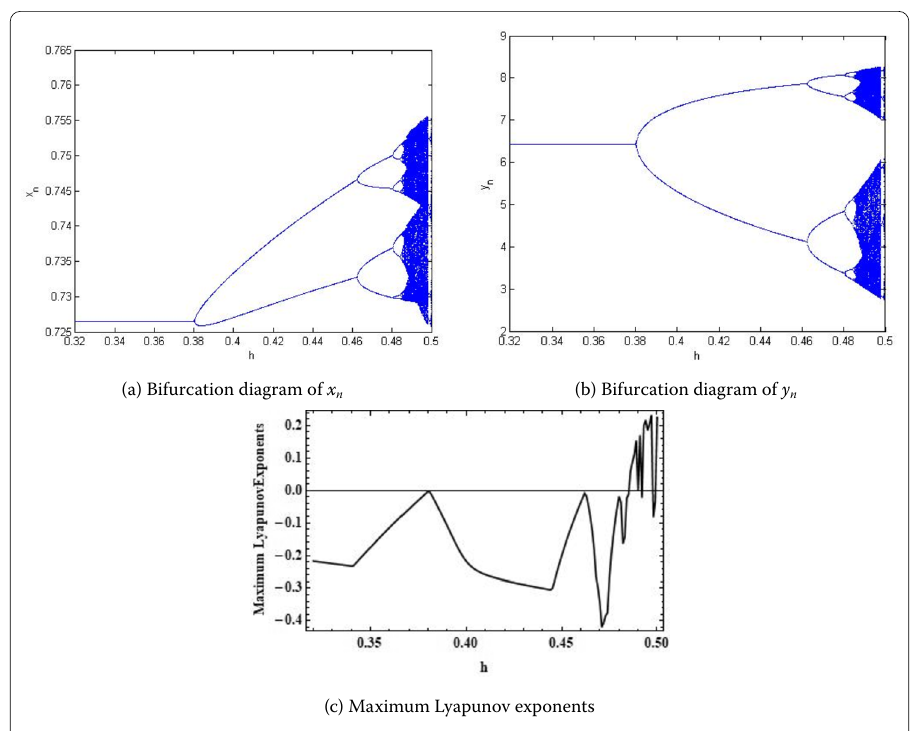
Figure 3 MLE and bifurcation diagrams for model (2) in the interval 0.32 ≤ h ≤ 0.5 with parameters ( a , b , c , d , α , β , h ) = (0.4,2,5.4,0.113,0.012,6,0.3805) and initial conditions ( x 0 , y 0 ) =